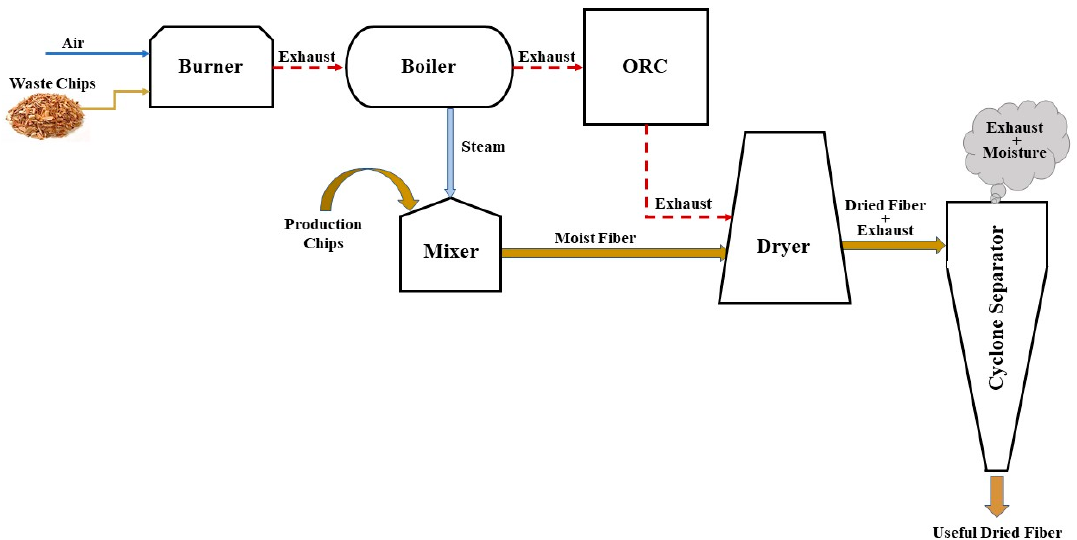
Figure 1. The schematic representation of the cogeneration system.